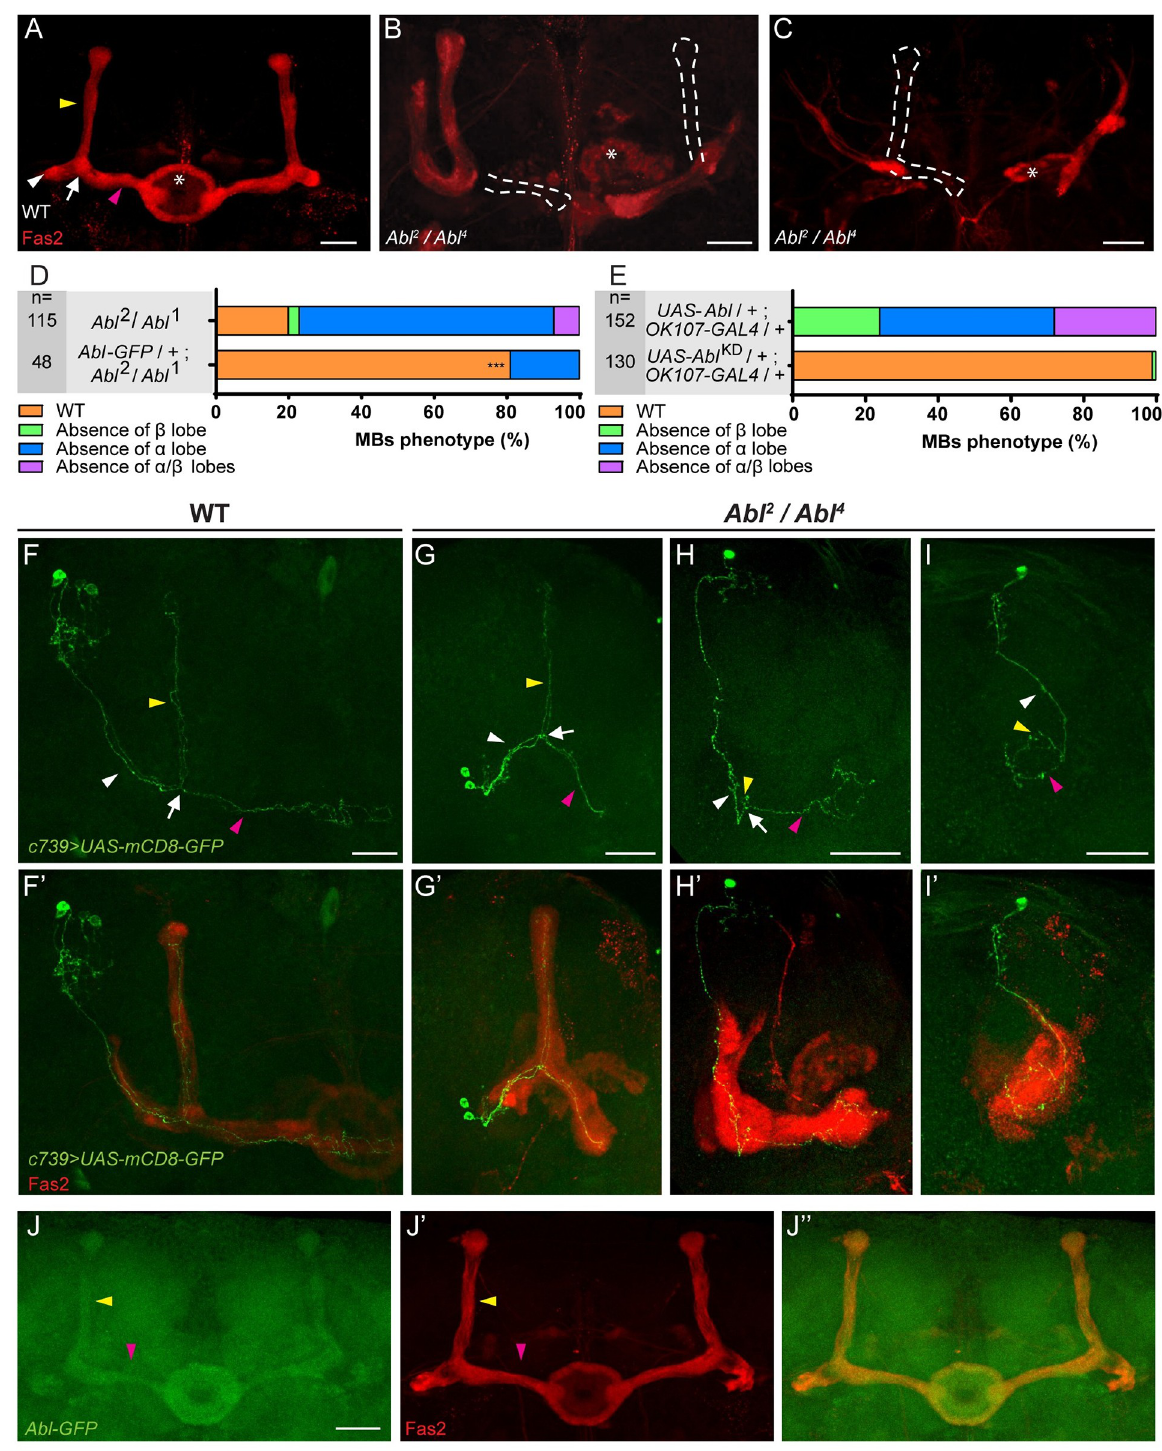
Fig 3. Either loss or overexpression of Abl affect MB αβ neuron morphology. (A-C) Anti-Fas2 staining on wild-type (WT) brain (A) and on Abl 2 /Abl 4 brain (B-C). In a wild-type (WT) brain, the α lobe (indicated by yellow arrowhead) projects vertically and the β lobe, indicated by pink arrowhead, projects toward the midline and stops before reaching it. The loss of the β and α lobes (B) and of both the α and β lobes (C) is emphasized by white dashed lines. � shows the ellipsoid body. (D) Quantitation of the αβ neuron mutant phenotype in the Abl 2 /Abl 1 mutant and rescued brains with the Abl-GFP genomic transgene. n = number of MB observed and ��� P < 0.001 (Fisher exact test). Transgenic expression of